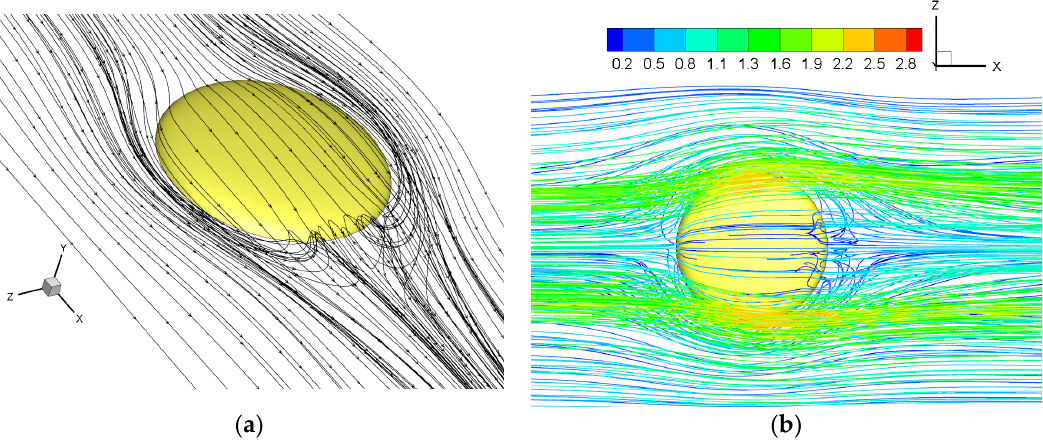
Figure 24. 3D streamline distribution with ( b ) and without ( a ) velocity magnitude contour near protrusion (unit: m · s − 1 ).